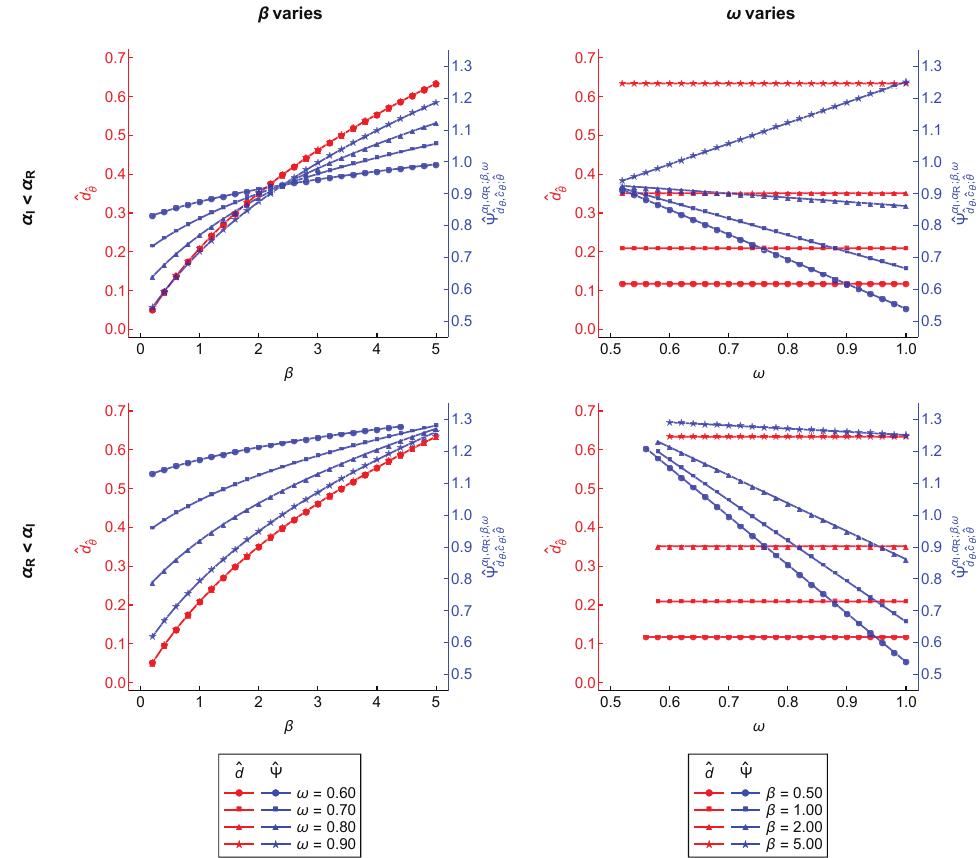
Figure 9. The estimates for the optimal retention limit (red line) and the minimized objective function (blue line) for the combined stop-loss and quota-share reinsurance when β varies (on the left side) and when ω varies (on the right side). They are determined according to the estimated Pareto distribution for the claim data when α I ( =0.05 ) < α R ( =0.07 ) (on the upper side) and when α R ( =0.03 ) < α I ( =0.05 ) (on the lower